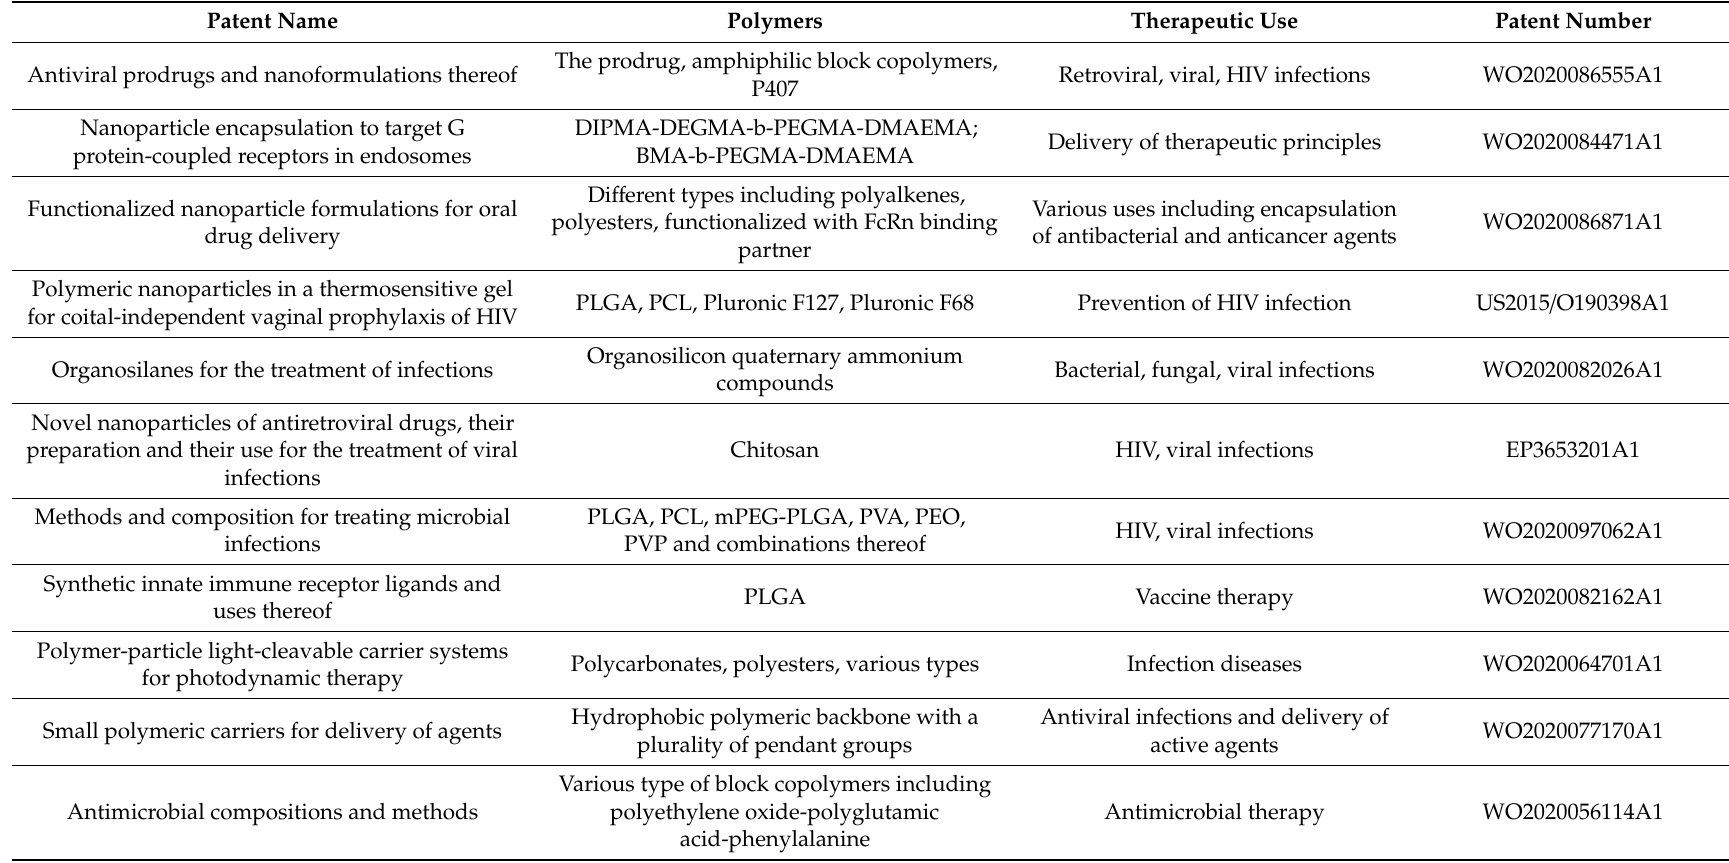
Table 4. Some recent patents adjudged in 2020 about PNs to treat intracellular